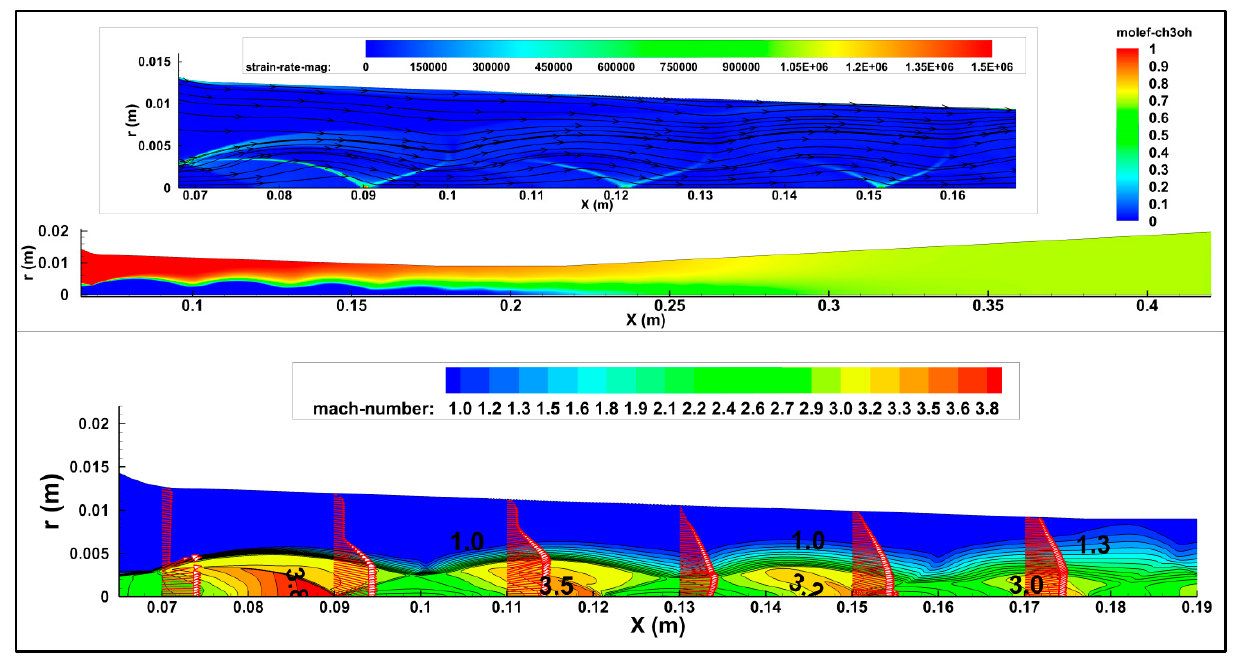
Figure 4. Flow dynamics inside the ejector at a compression ratio of 2.16 for the CF2I2-CH3OH fluid pair.